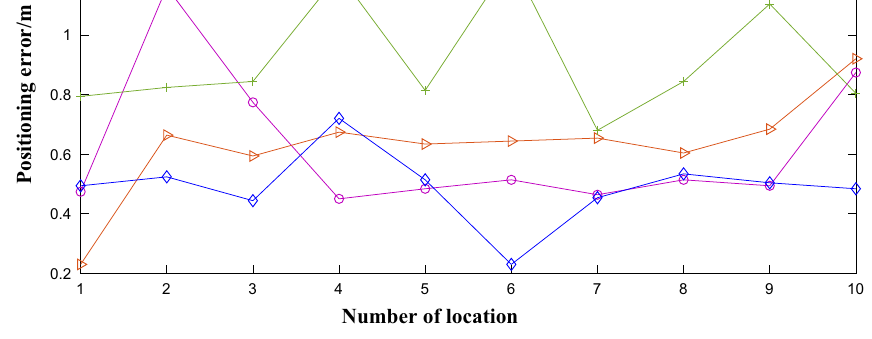
Figure 16. The legend of Table 3.